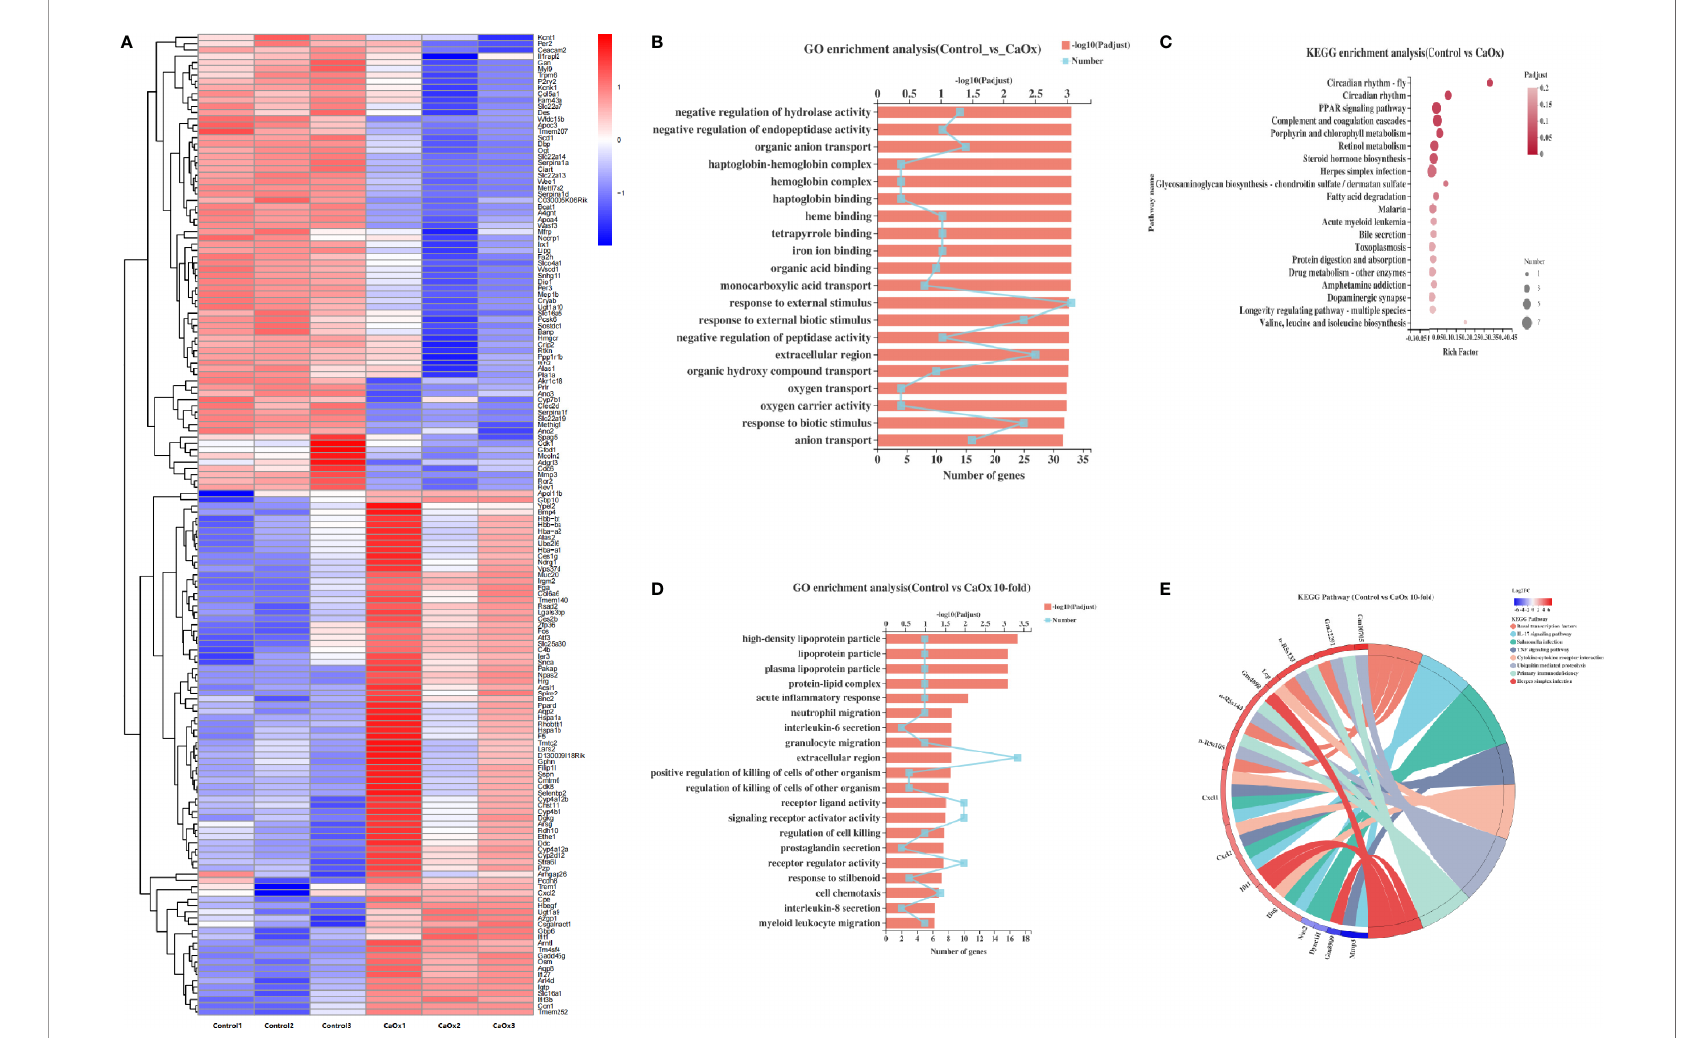
FIGURE 4 | Transcriptional features of CD45 + cells in kidney of CaOx crystal mice. (A) Differentially expressed genes (DEGs) between control and CaOx mice. (B) GO (Gene Ontology) analyses of DEGs (P adjust<0.05, FC ≧ 2 and FC ≦ 0.5). (C) KEGG (Kyoto Encyclopedia of Genes and Genomes) analyses of DEGs (P adjust<0.05, FC ≧ 2 and FC ≦ 0.5). (D) GO analyses of DEGs (P adjust<0.05, FC ≧ 10 and FC ≦ 0.1). (E) KEGG analyses of DEGs (P adjust<0.05, FC ≧ 10 and FC ≦ 0.1), and KEGG pathways invlovled genes (P adjust<0.05, FC ≧ 10 and FC ≦